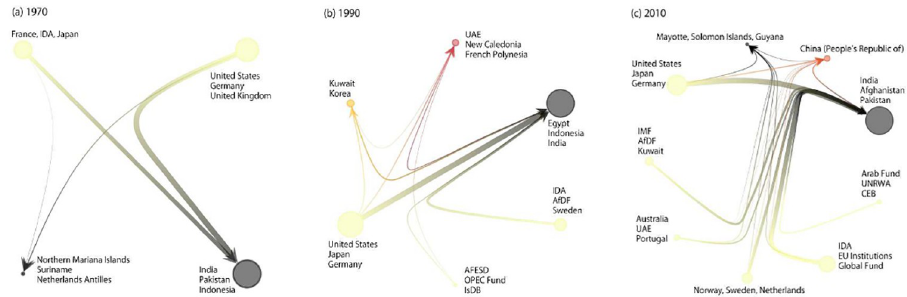
Fig 3. Aid flow networks of blocks. A coarse-grained representation of the FANs in (a) 1970, (b) 1990, and (c) 2010, where the nodes in this figure represent the blocks. The edges show the aid flow between the nodes in each block. The aid flow from block b 1 to block b 2 is the total aid given by actors in b 1 to actors in b 2 . The size of the nodes depends on the total inward and outward aid flow summed over all members of the blocks. The labels show the names of the actors with the three largest inward and outward aid flows in each block. The brightness of the blocks indicates the fractions of outward aid flow, in other words, bright blocks mainly contain donors. The edge width shows the volume of aid